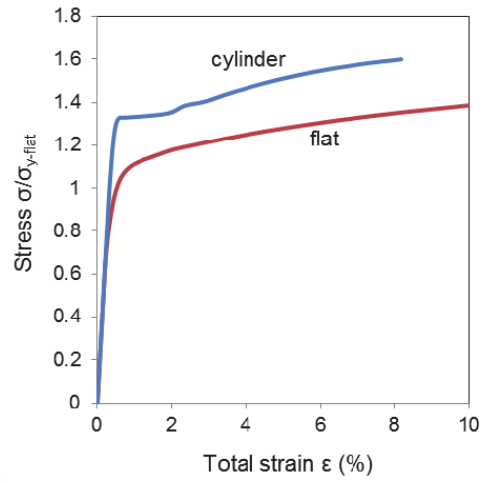
Figure 1: Monotonic elastic-plastic material laws of the flat and cylinder components